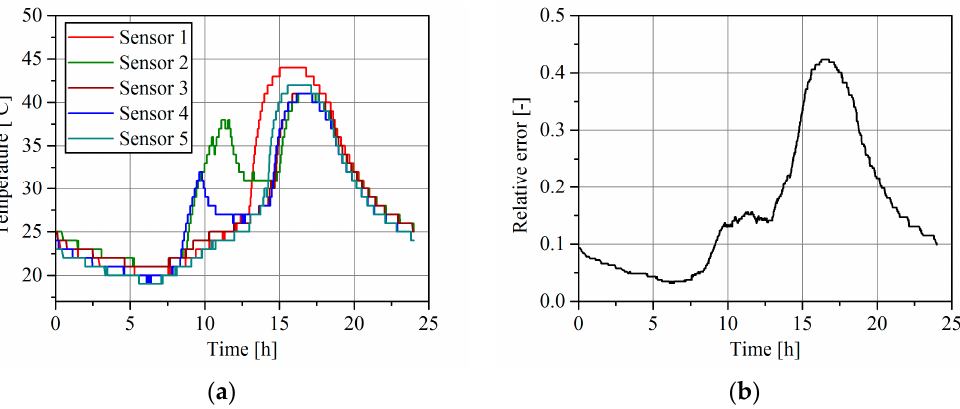
Figure 5. ( a ) Daily pavement temperature change at the MS-WIM site at five measurement points, distributed along the site; ( b ) A sample daily variation of the weighing error (1) at the MS-WIM site due to the pavement temperature change.